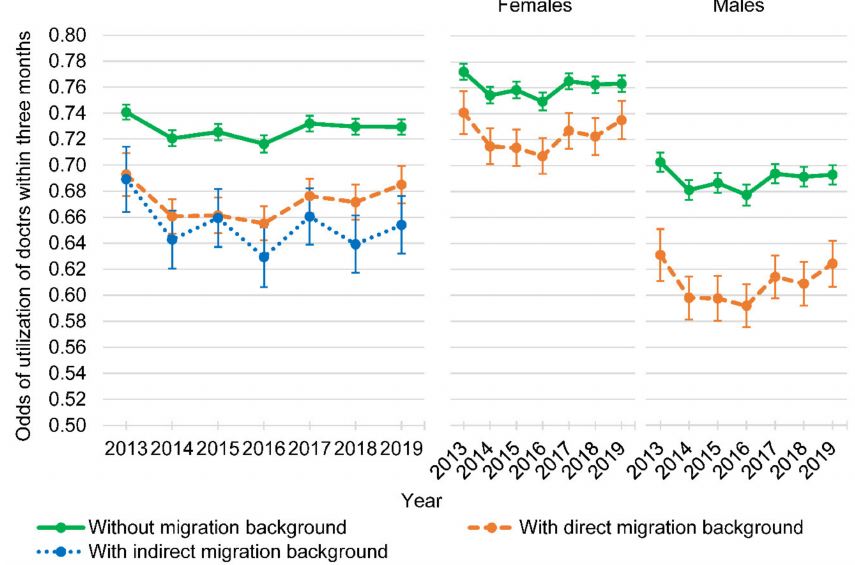
Figure 1. Adjusted odds of utilization of doctors within three months of persons without and with direct or indirect migration background, and for females and males without and with direct migration background (years 2013 to 2019, n = 43,921; 179,357